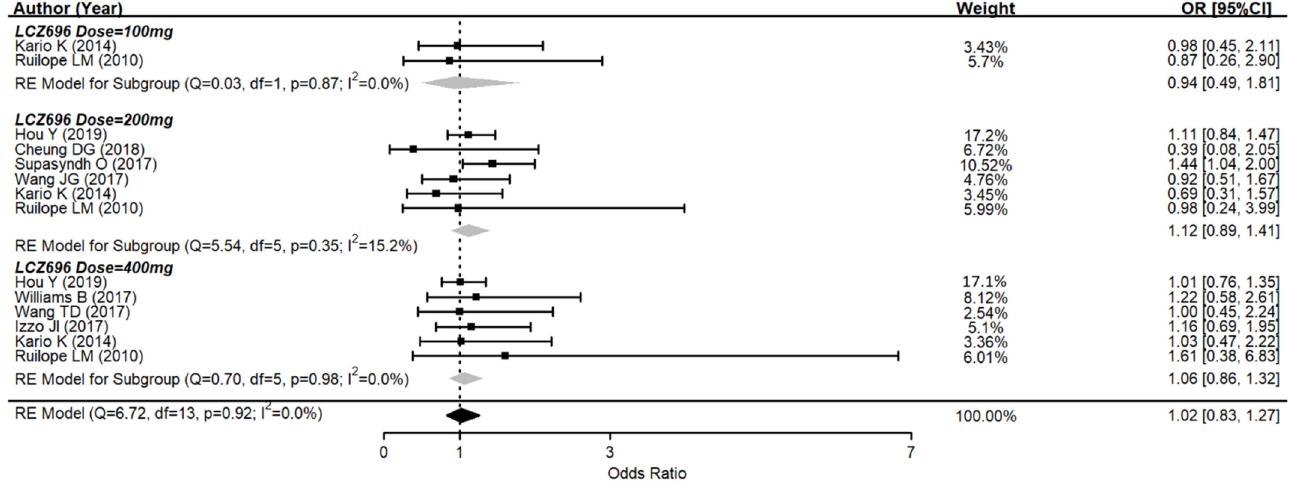
Figure 4. Forest plot of trial-defined adverse events. Comparisons between LCZ696 and a control group.